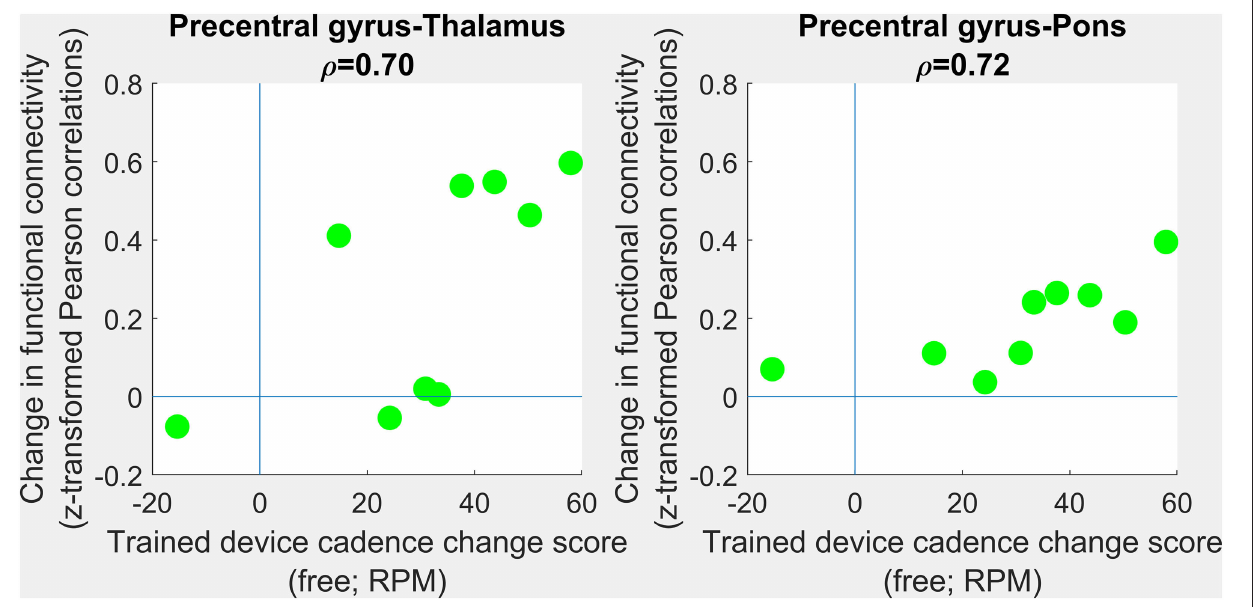
FIGURE 4 | Correlations between changes in functional connectivity and response to intervention. PRE- to POST-intervention changes in functional connectivity were assessed in terms of association with PRE- to POST-intervention improvements in trained-device cadence. No group-level differences survived multiple comparisons correction. Scatterplots show trends toward improvements in free cadence associated with increases in precentral gray matter-to-thalamus (left) and precentral gray matter-to-pons (right) functional connectivity. Each green circle corresponding to one